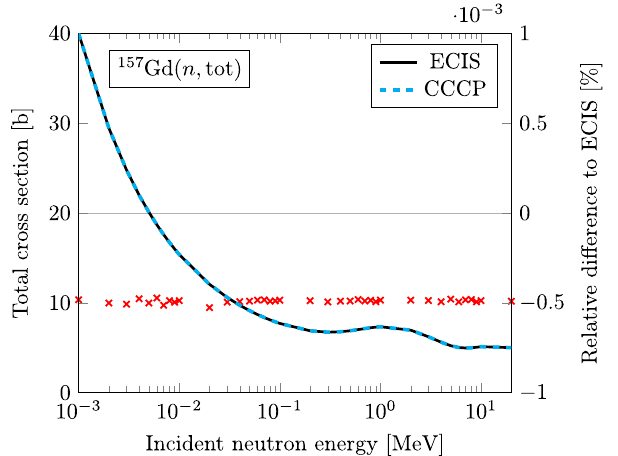
Fig. 7. TALYS1.4/CONRAD (n, γ ) cross section comparisons on 56